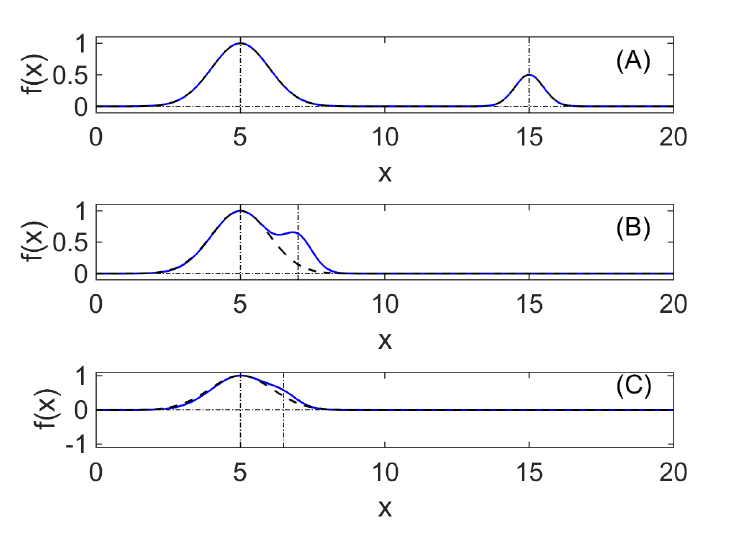
Figure 3. Blue solid lines correspond to the functions combined from two Gaussians with different parameters. The functions plotted in subpanels ( A – C ) are the same as in Figure 2 denoted by the respective letters. Dashed black lines depict results of a primary run of the features extraction algorithm described in Section 3.1 (note that original and recovered curves in the subpanel ( A ) coincide practically perfectly). Vertical dash-dotted lines indicate exact peak positions for individual